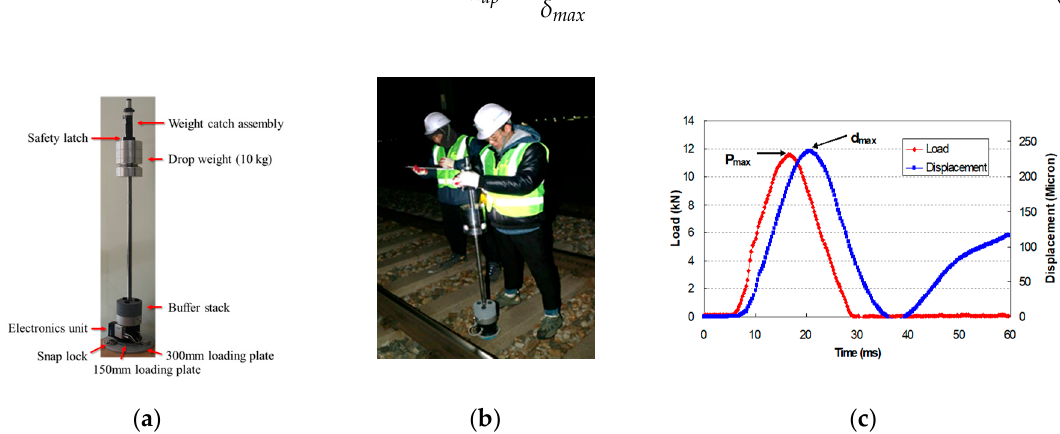
Figure 1. Light falling weight deflectometer (LFWD) testing: ( a ) LFWD equipment; ( b ) Field test; ( c ) Measured data.